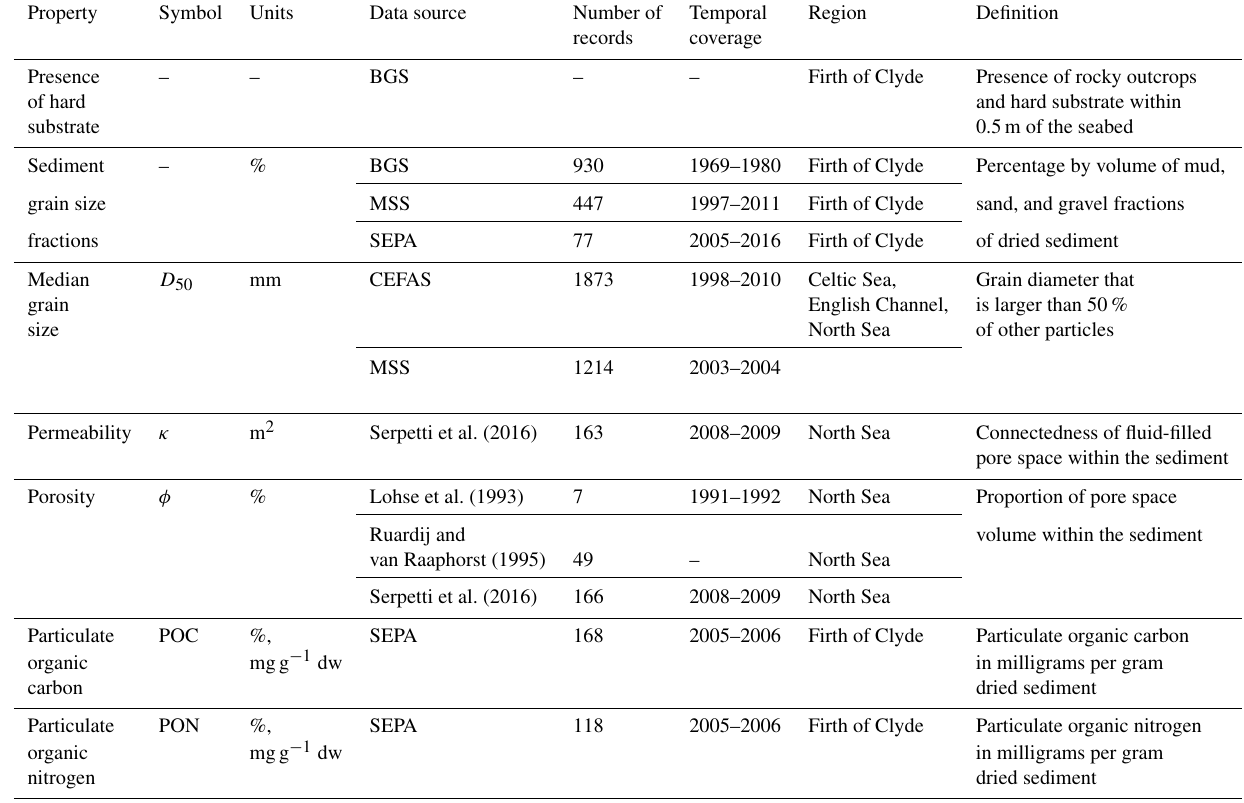
Figure 1. Maps of the Firth of Clyde showing (a) locations referred to in text and (b) bathymetry mapped over an unstructured grid. Seabed depth is shown in metres, and the dashed line shows the outer geographical limits of the Firth of Clyde. The location of the Firth of Clyde on the west coast of Scotland is shown inset. Bathymetry data source: Sabatino et al. (2016). Table 1. Sources of seabed data from data centres and the published literature and the number of records used from each source. Sources include the British Geological Survey (BGS); Marine Scotland Science (MSS); the Scottish Environmental Protection Agency (SEPA); and the Centre for Environment, Fisheries and Aquaculture Science (CEFAS). Dry weight: dw.